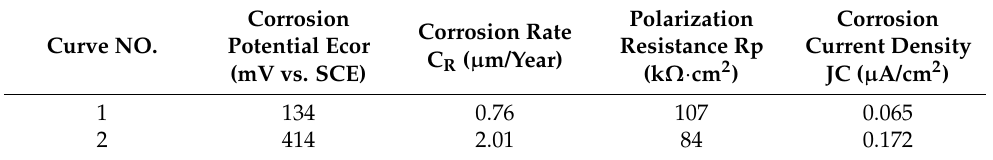
Table 4. Corrosion properties obtained by Tafel extrapolation. Corrosion Curve NO.